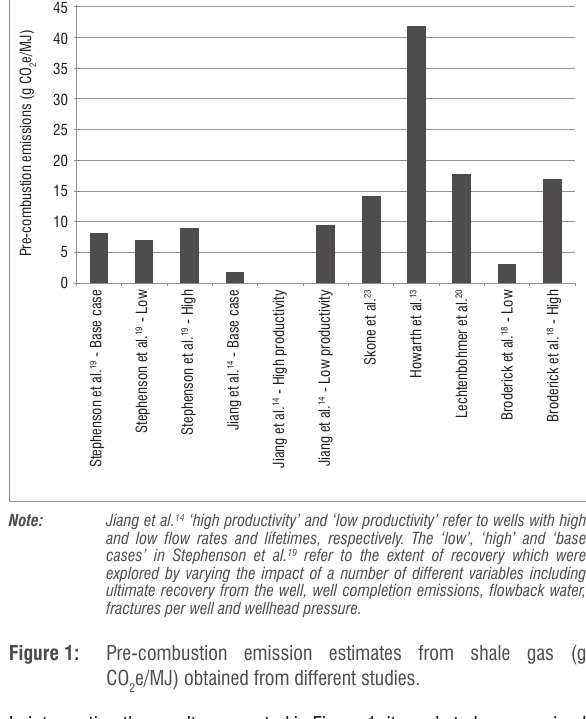
e/MJ) from shale gas 2 Stephenson et al. 19 Jiang et al. 14 Skone et al. 23 Howarth et al. 13 Lechtenböhmer et al. 20 Broderick et al. 18 Base High Low Base case Low High case productivity productivity Low